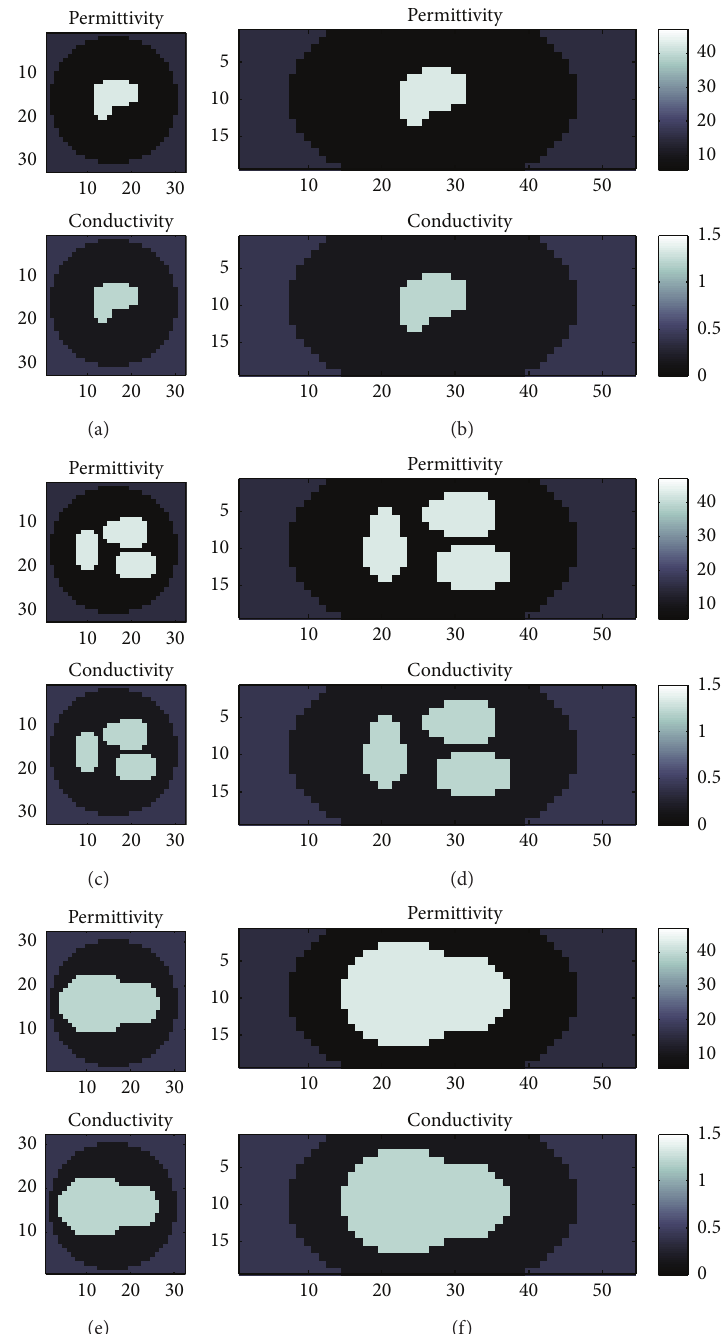
Figure 2: Six phantoms used in the reconstructions with (b, d, f) and without compression (a, c, e). (a) and (b) Mostly fatty phantom without and with compression. (c) and (d) Scattered fibroglandular phantom without and with compression. (e) and (f) Very dense phantom without and with